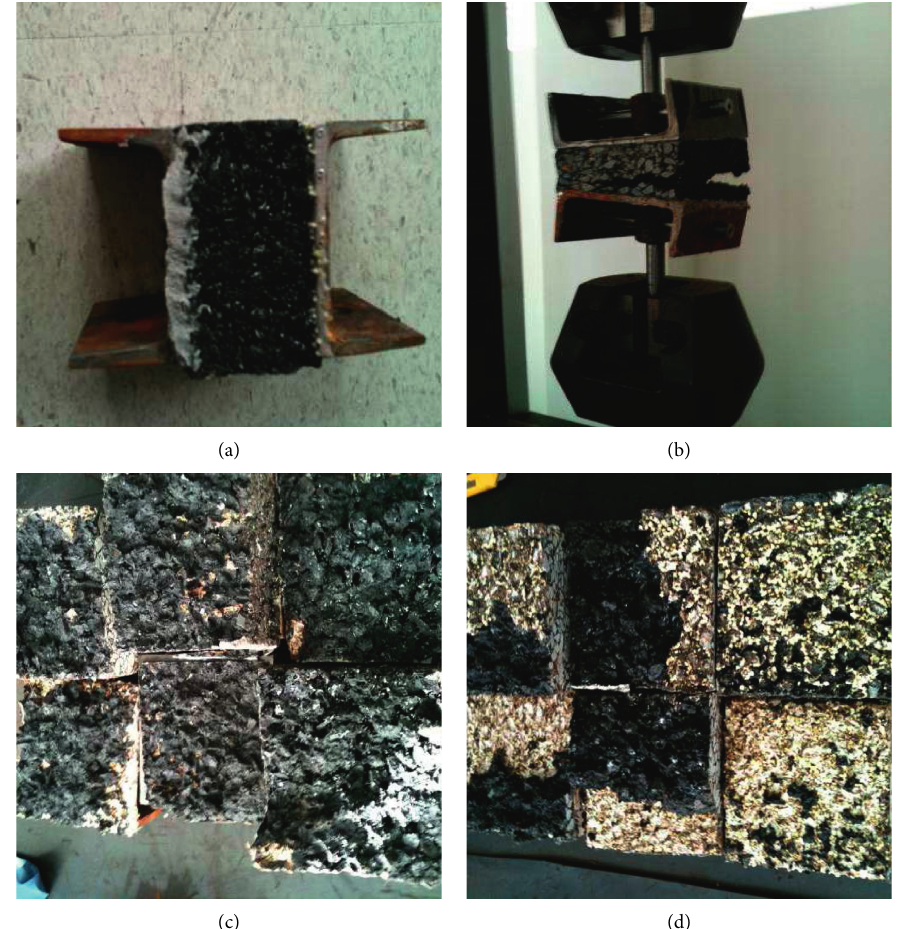
Figure 9: Direct tension test. (a) Specimen preparation. (b) Test setup. (c) Failure of SMA (25 ° C and 60 ° C). (d) Interface debonding (70 ° C).